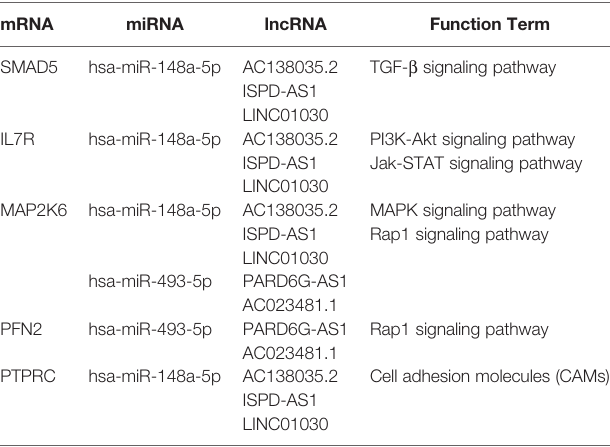
TABLE 2 | Cancer-Related lncRNA-miRNA-mRNA Axis.